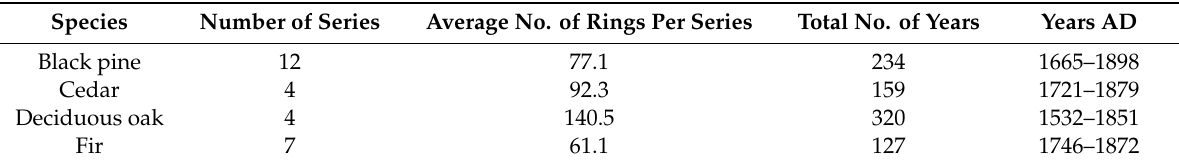
Table 2. Mean chronologies per species for historical timber from Symi.